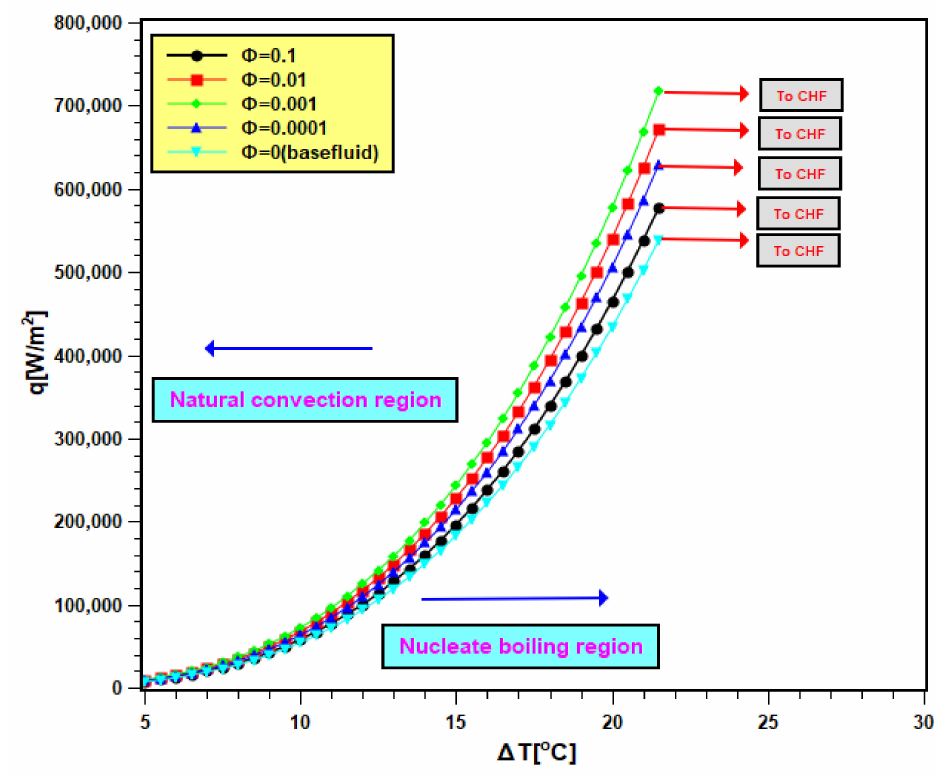
Figure 10. Boiling heat transfer characteristics curve of